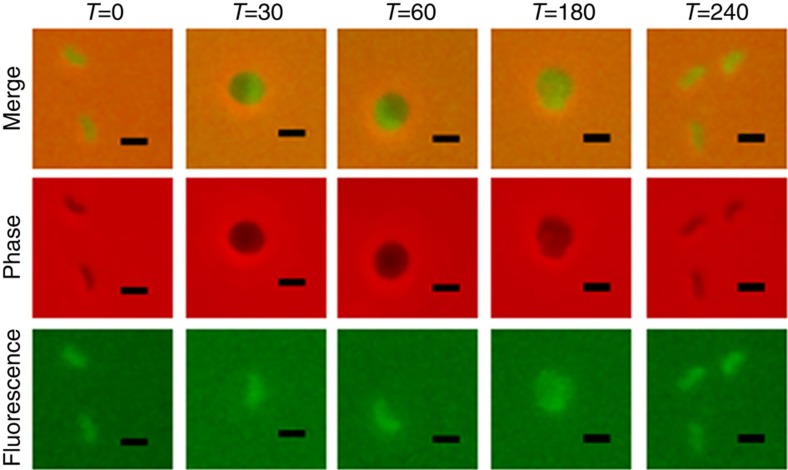
Periplasmic localization of Bd3460 protein.Epifluorescence phase contrast microscopy of Bdellovibrio with a Bd3460::mCherry tag. Fluorescence is seen in the small, attack phase cells at times 0 and 240 min, and increases as the Bdellovibrio enter the prey, which rounds up to form a ‘bdelloplast'. As the Bdellovibrio cell grows inside the bdelloplast, the fluorescence becomes dissipated in the larger, cylindrical cell (T=180 min). Scale bar, 1 μm.